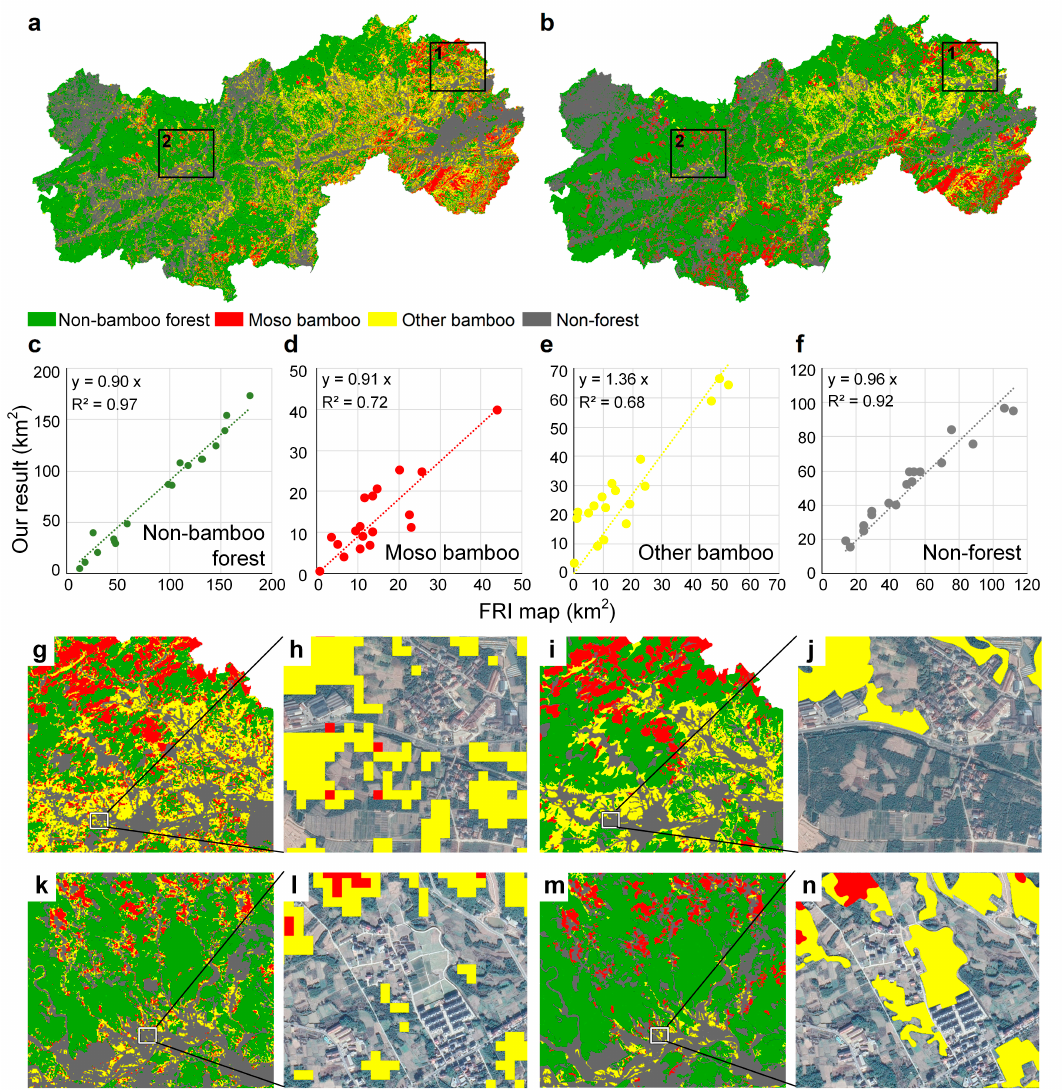
Figure 3. Comparison of the late 2010s bamboo forest map generated in this study ( a ) and the Forest Resources Inventory (FRI) map from 2017 ( b ). ( c – f ) Area comparisons of the two maps at the subdistrict / township level. Linear fits with the intercept forced to 0. ( g , i ) and ( k , m ) show zoom-in regions of the two regions labeled 1, 2 in Figure 3a,b. ( h , j ) and ( l , n ) show zoom-in views of the regions indicated by the white boxes in ( g , i ) and ( k , m ). The background images for ( h , j ) and ( l , n ) are taken from Google Earth dated 3 November 2017 and 9 November 2017, respectively.